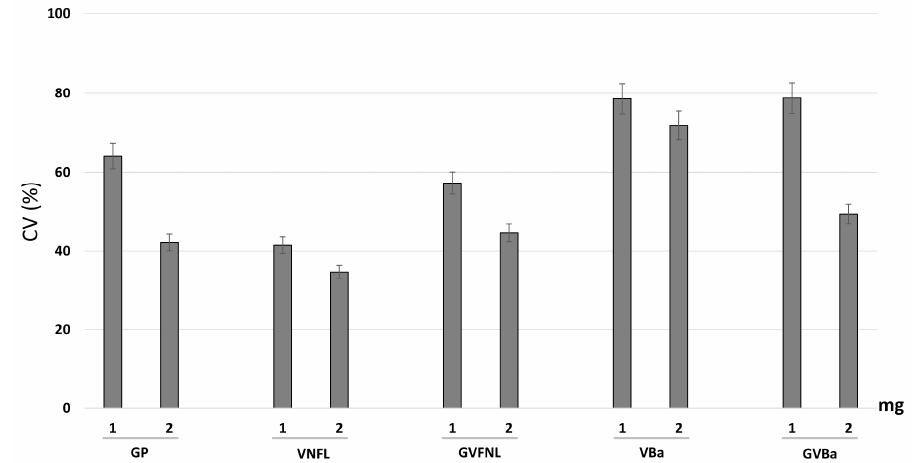
Figure 6. Cell viability in terms of mitochondrial redox activity at 48 h of exposure time by means of MTT (3-(4,5-dimethyl-2-thiazolyl)-2,5-diphenyl-2H-tetrazolium bromide) test results. Values, reported as percentage vs. an untreated control (100% cell viability), are the means ± SD of measurements carried out on three samples ( n = 3) analyzed three times.